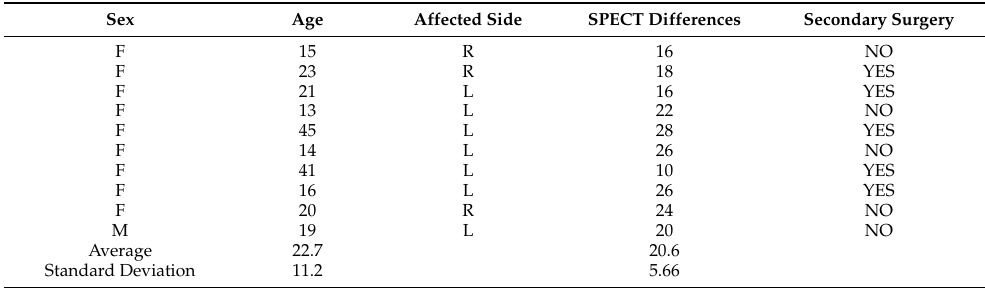
Table 3. Distribution of subjects with UCH according to clinical type II.